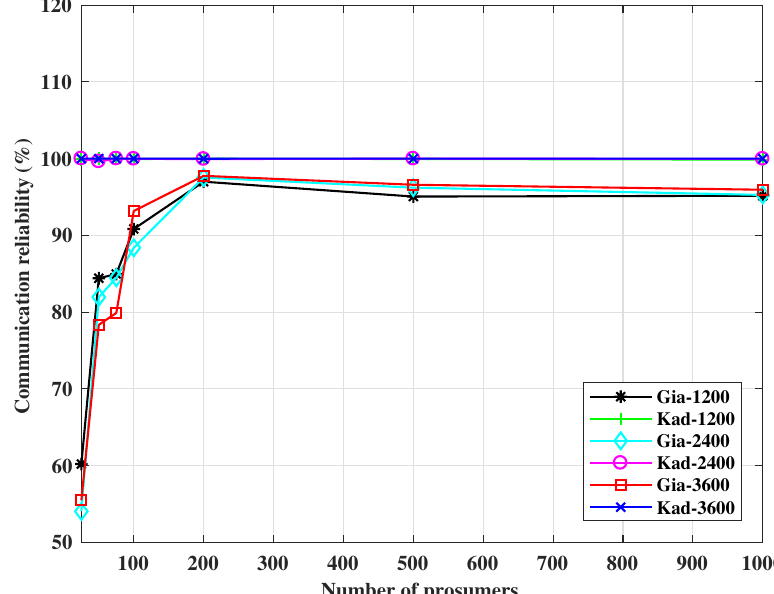
Figure 11. Performance evaluation of Kademlia and Gia P2P protocols for reliable